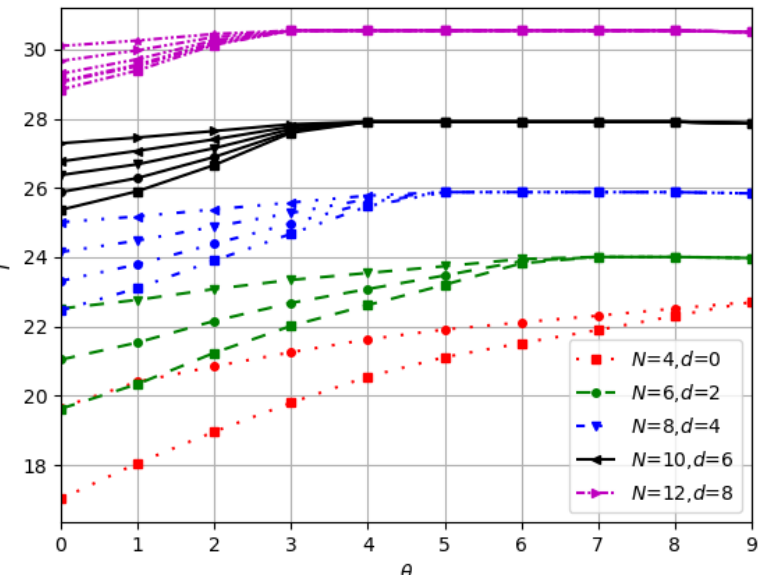
Figure 8. Mean spending time for families of curves with two parameters: N (indicated by color), and d (indicated by